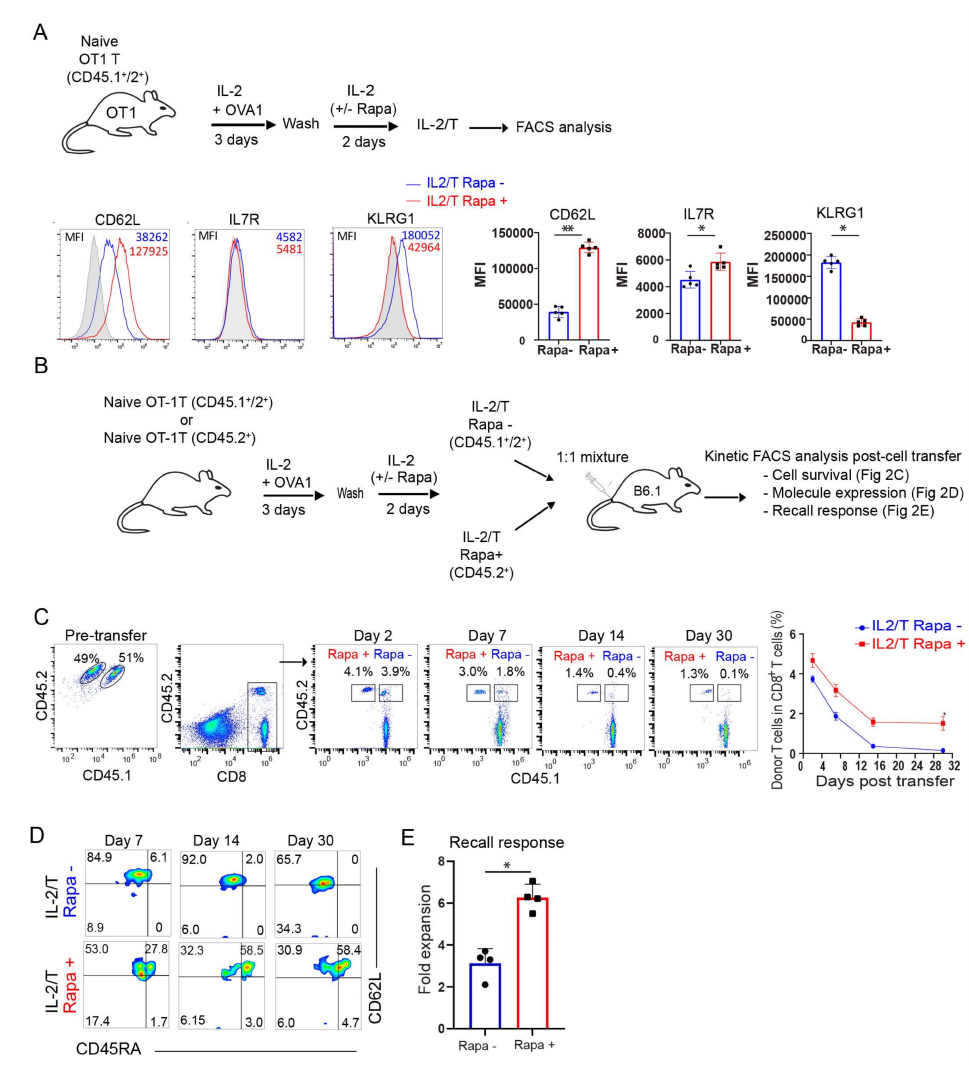
Flow cytometry analysis of mouse peripheral blood 4 d post-infection showed that T M cells derived from IL-2(Rapa+)/T-cells exhibited roughly a 2-fold greater expansion than T M cells derived from IL-2/T-cells (Figure 2E).